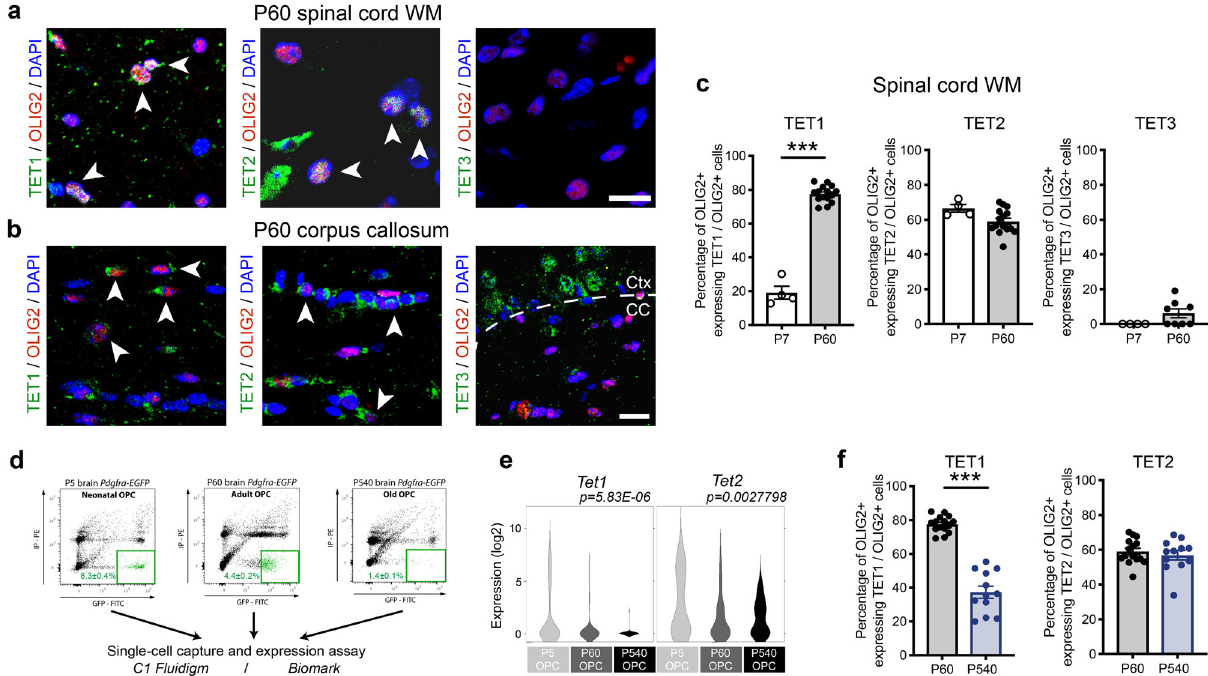
Fig. 2 TET1 and TET2 are the most abundant isoforms in OLIG2 + cells in the adult spinal cord, with only TET1 displaying an age-dependent decline. a , b Representative confocal images of coronal spinal cord ( a ) and brain ( b ) sections from adult mice (P60) stained with antibodies speci fi c for the indicated TET isoforms (green) and for OLIG2 (in red). White arrowheads indicate co-labeled cells. Scale bar = 50 μ m. c Percentage of OLIG2 + cells expressing TET1, TET2, or TET3 in postnatal P7 and adult P60 spinal cord. Error bars represent SEM for n = 4 (for neonates) and n = 22 (for adult) samples (*** p < 0.001 for TET1, p = 0.0640 for TET2, p = 0.1281 for TET3, Student ’ s t test two-tailed). d Representative fl uorescence-activated cell sorting plots of oligodendrocyte progenitor cells isolated from Pdgfr α -H2BEGFP reporter mice at neonatal (P5, nOPC), adult (P60, aOPC), and old (P540, oOPC) age. Single-cells were captured and RNA extracted using micro fl uidics (C1Fluidigm), coupled to RT-qPCR for single-cells, using Biomark. e Violin plots of Tet1 and Tet2 in nOPC ( n = 61), aOPC ( n = 76), and oOPC ( n = 51) reveal a signi fi cant and sharp age-dependent decline of Tet1 and to a much lesser extent of Tet2 expression. Data represent log2 expression, derived from Ct (one-way ANOVA, factors age). f Bar graphs show the percentage of TET1 or TET2 expressing OLIG2 + cells in young and old spinal cord sections. Average counts in 3 – 4 sections per mouse for n = 22 (young) and n = 6 (old) mice, error bars represent SEM (*** p < 0.001 for TET1, p = 0.5050 for TET2, Student ’ s t test